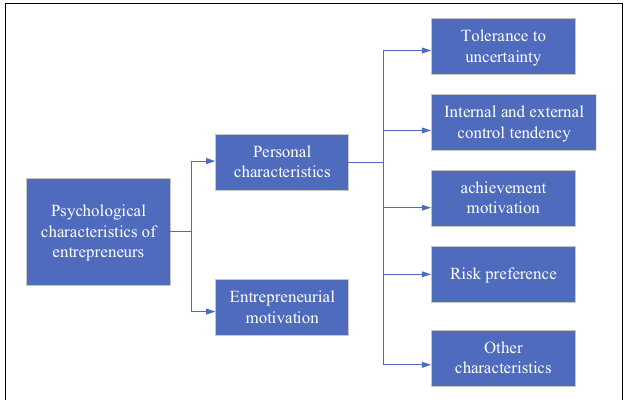
FIGURE 2 | Psychological characteristics of new